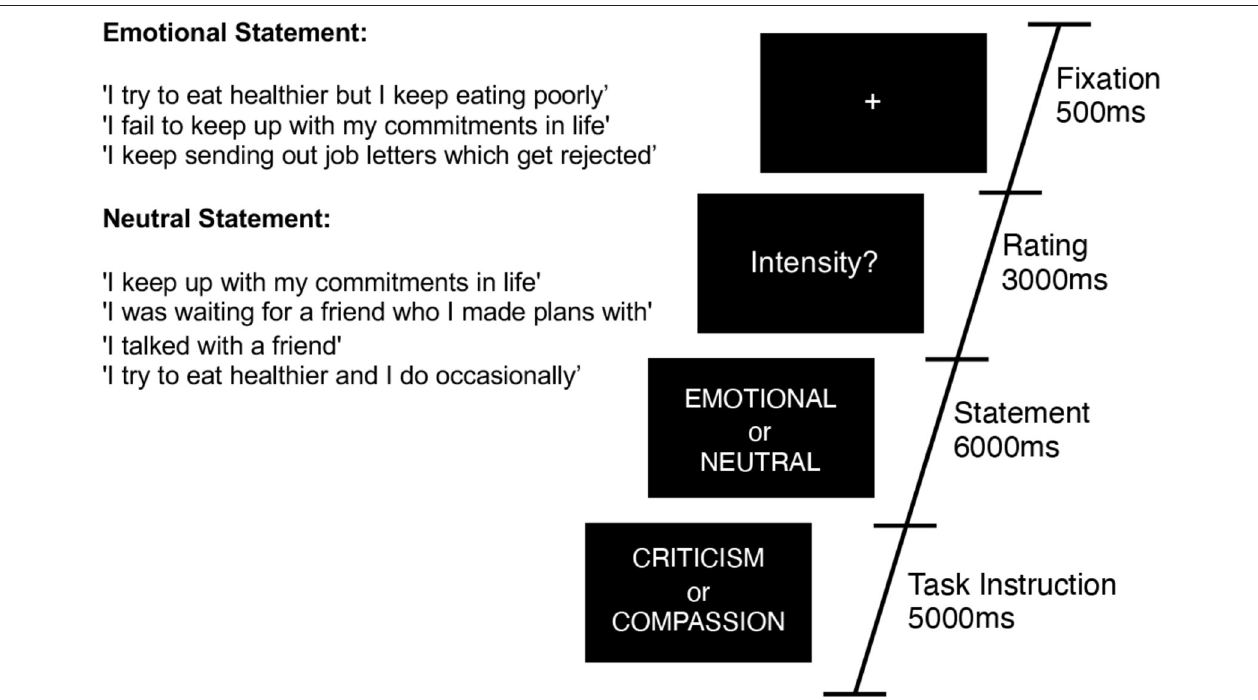
FIGURE 1 | Task diagram for a typical trial. Participants were presented with 30 alternating trials of emotional or neutral statements which describe a mistake, setback or failure. Across scan runs of 6min each, participants were asked to engage with these statements from two different perspectives—four blocks of self-criticism, and four blocks of self-reassurance (order counterbalanced across participants). Example statements are presented